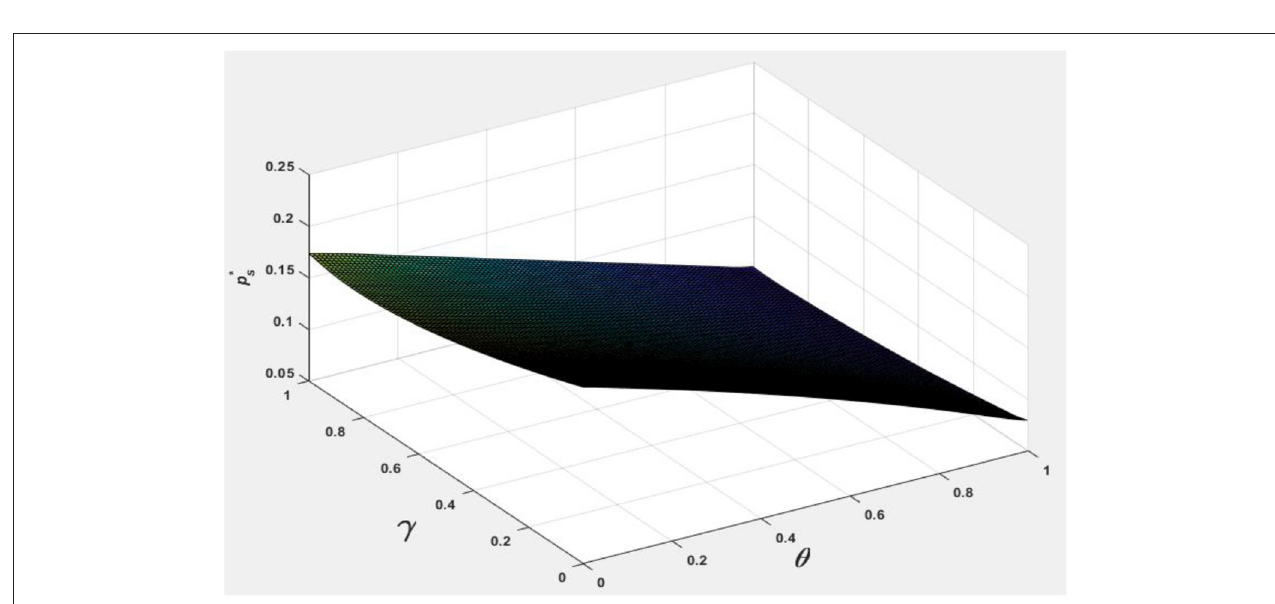
FIGURE 5 | Effect of θ , γ on p * s